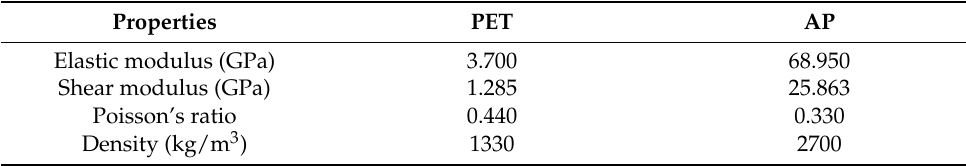
Table 1. Properties of polyethylene terephthalate (PET) and Al powder (AP).